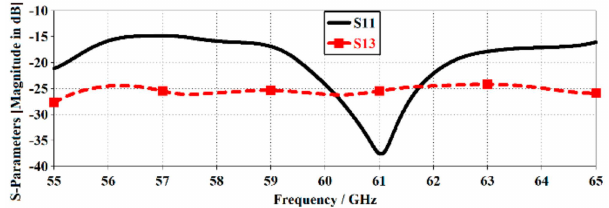
Figure 2. S-parameter responses of the proposed array antennas. Since the structure is symmetrical, we have not plotted all